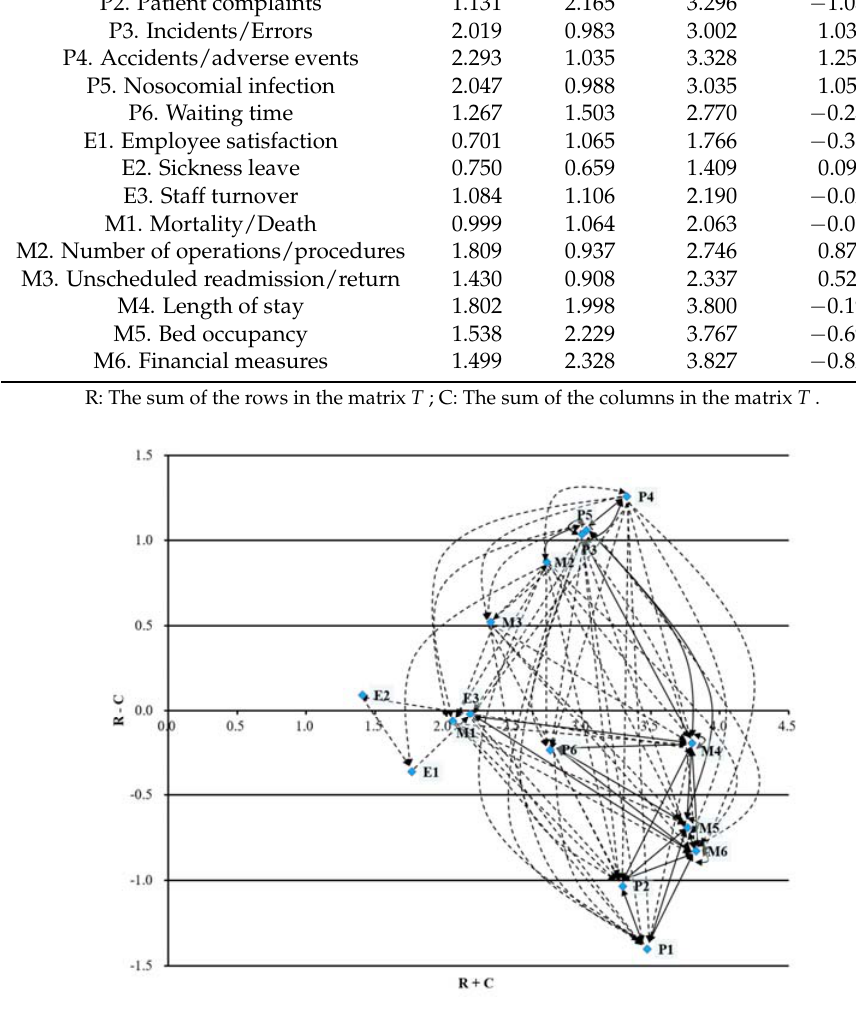
Figure 2. Influential relation diagram for the example.